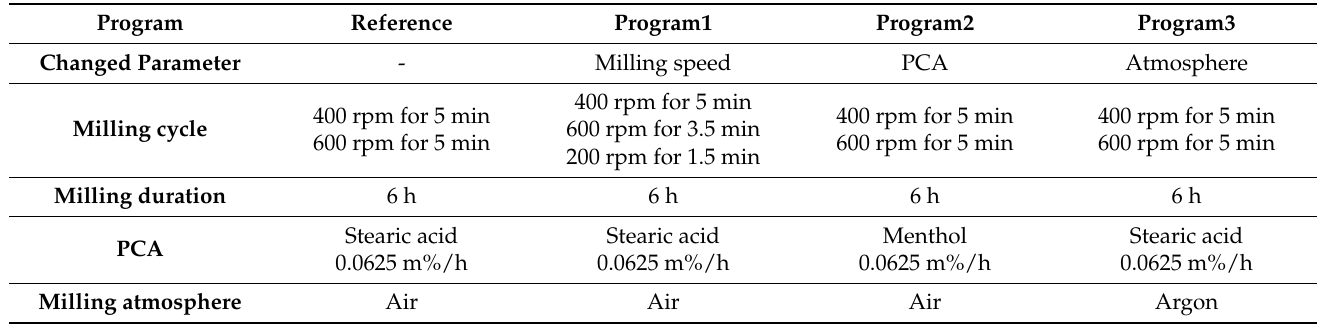
Table 2. Variation of milling parameters compared to the reference milling program.